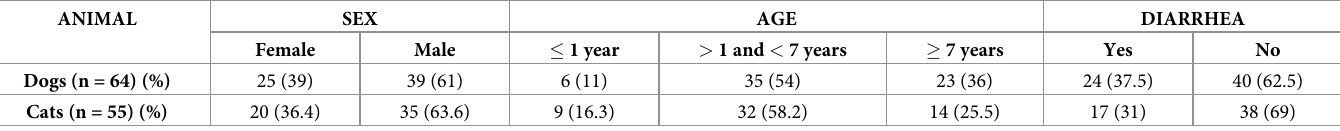
Table 1. Percentage information on sex, age, and presence or absence of diarrhea in the population of dogs and cats (n = 119) in the neighborhood of Campo Grande, Rio de Janeiro, Brazil. ANIMAL SEX AGE DIARRHEA Female Male � 1 year > 1 and < 7